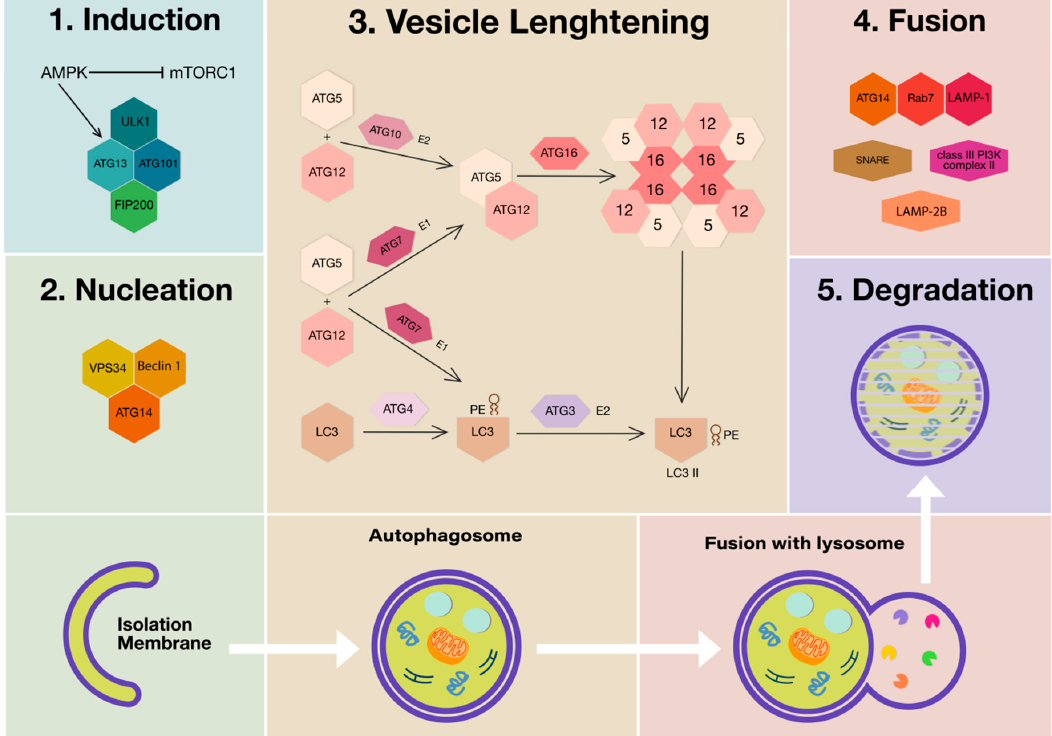
Figure 1. Schematic representation of mammalian autophagy molecular mechanisms. The inhibition of the mammalian target of rapamycin complex 1 (mTORC1) by AMP-activated protein kinase (AMPK), following nutrient deprivation due to accumulation of AMP, allows autophagy to start (1. Induction). AMPK sequentially phosphorylates and activates autophagy-activating kinase 1 (ULK1), autophagy-related (ATG)13, ATG101, Vps34 and Beclin 1 to nucleate the formation of phagophore (2. Nucleation). The recruitment of two ubiquitin-like conjugation systems, ATG10 (E2) and ATG7 (E1), catalyzes the formation of the multimeric complex (ATG12, ATG5, and ATG16). This complex, together with microtubule-associated protein 1A/1B-light chain 3 (LC3)-phosphatidylethanolamine (PE), derived from the action of ubiquitin-like conjugation systems ATG7 (E1), are part of the vesicle elongation process (3. Vesicle lengthening). Next, mammalian ATG8 family members LC3 and GABARAPs mediate the phagophore membrane closure (4. Fusion). Autophagosomes fuse with lysosomes under the regulation of cytoskeleton elements. Various proteins including ATG14, lysosomal-associated membrane protein (LAMP)-1, LAMP-2B, Rab7 and soluble N-ethylmaleimide-sensitive factor-activating membrane fusion protein (SNARE) participate to the formation of the autolysosome, where the degradation of cargo occurs by the action of lysosomal enzymes (5. Degradation). Abbreviations: AMPK, AMP-activated protein kinase; ULK1, unc-51-like autophagy-activating kinase 1; Vps34, phosphatidylinositol 3-kinase catalytic subunit type 3 (PIK3C3/Vps34); ATG, autophagy-related protein; ATG16L1, autophagy-related 16-like 1; PE, phosphatidylethanolamine; MAP1LC3B / LC3B, microtubule-associated protein 1 light chain 3 beta; GABARAPs, γ -aminobutyric acid type A receptor- associated proteins; LAMP-1, lysosomal-associated membrane protein 1; Rab7, Ras-related protein 7; SNARE, soluble N-ethylmaleimide-sensitive factor-activating membrane fusion protein.